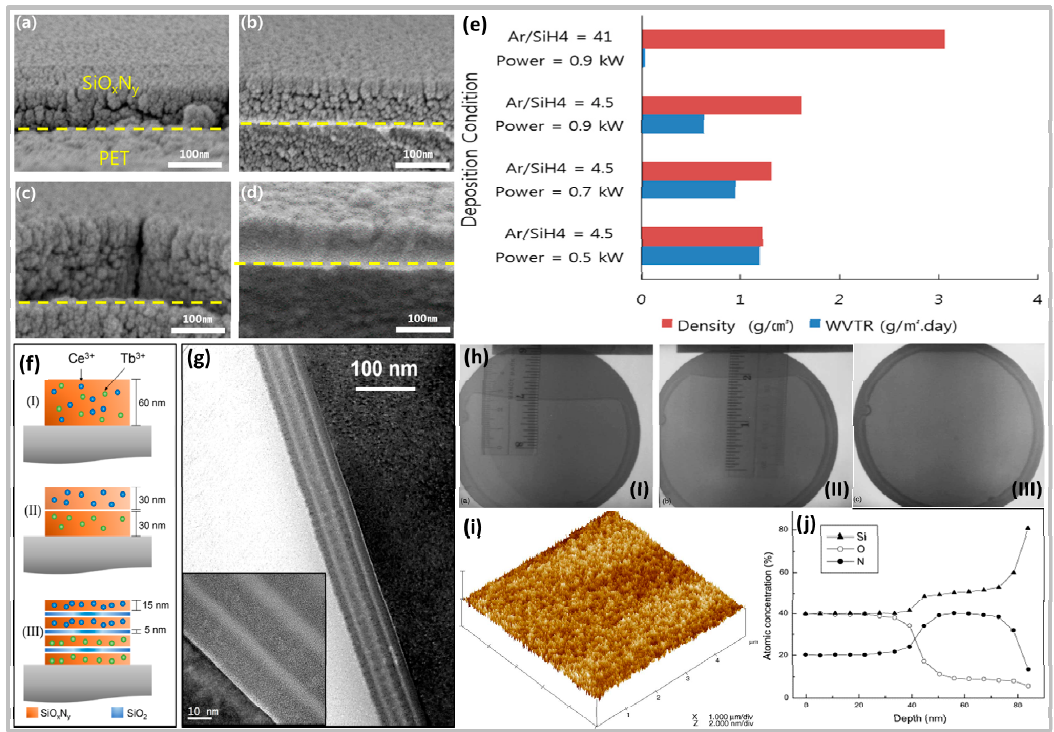
Figure 3. The surface morphology and performance of SiN x O y film are changed under di ff erent conditions. ( a – d ) FESEM cross-section images of SiN x O y film deposited at Ar / SiH 4 , O 2 / (O 2 + N 2 ) of